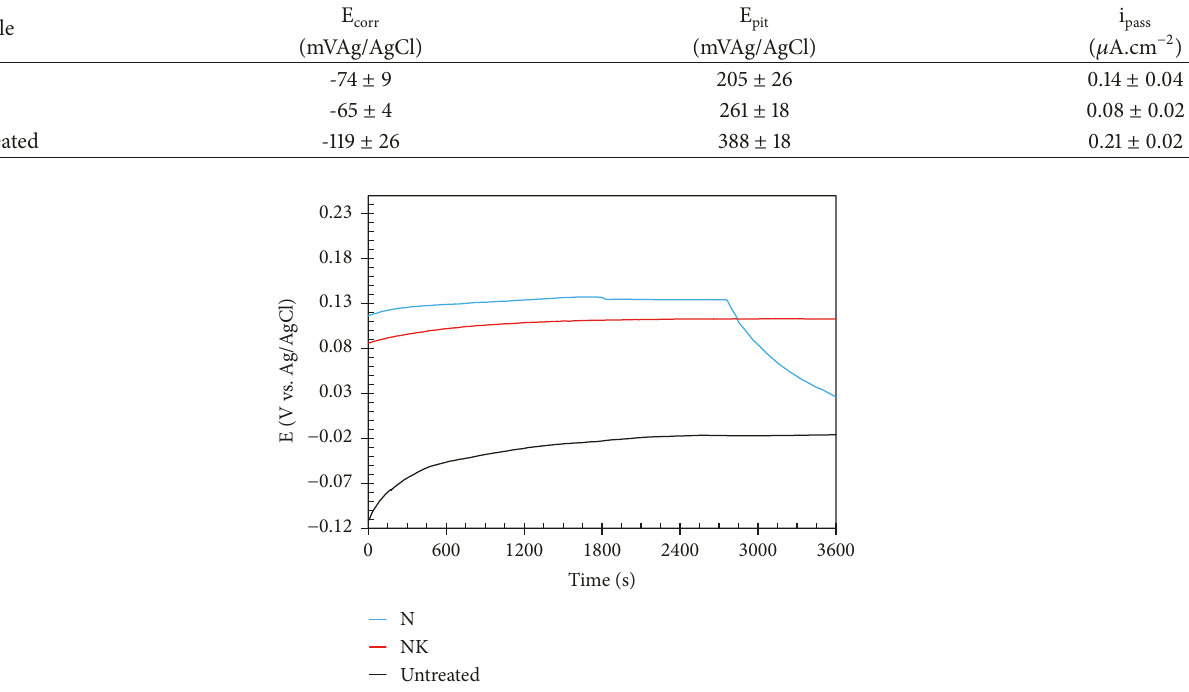
Figure 8: Variation of the open circuit potential with the immersion time for the untreated and nitrided samples. Electrolyte: 3.5 wt.% NaCl solution at room temperature.